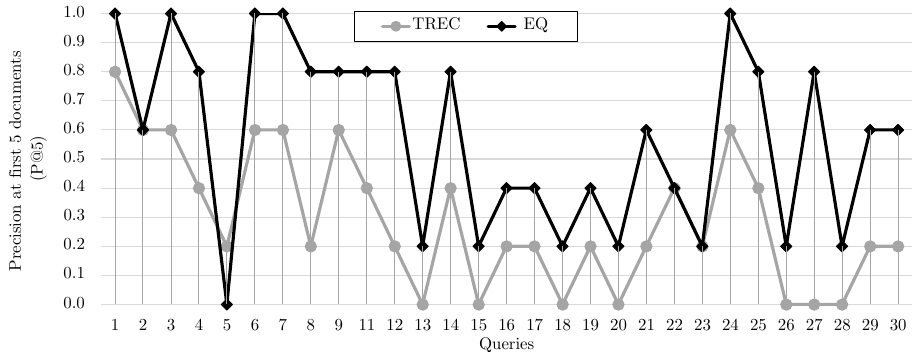
Figure 6. Comparison of the mean precision of the participants of the TREC2017 Precision Medicine Track (TREC) and the proposed method (EQ) in the top five retrieved documents.